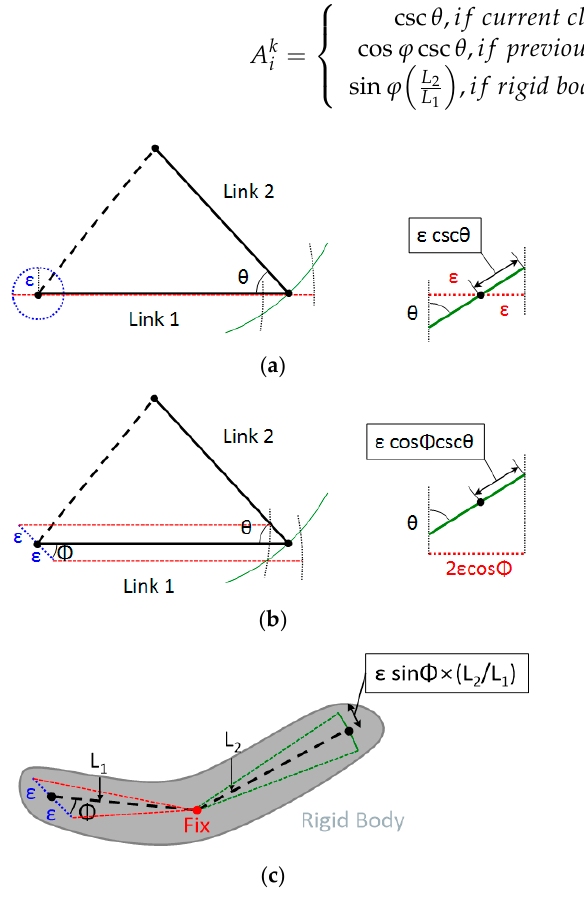
Figure 9. Amplification index. ( a ) Current clearance propagation. ( b ) Previous clearance propagation. ( c ) Rigid body clearance propagation.